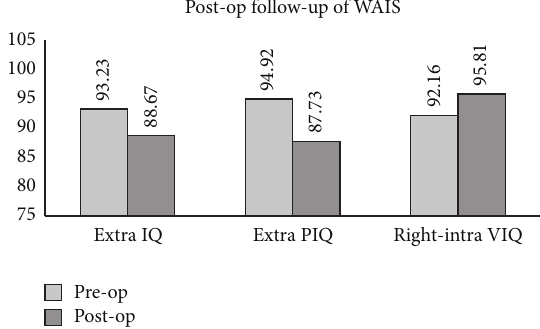
Figure 4: Significant decline of the IQ ( 𝑃 = .024 ) and PIQ ( 𝑃 = .004 ) was found in the extracerebral subgroup after surgery, and the VIQ of the right intracerebral subgroup significantly improved ( 𝑃 = .009